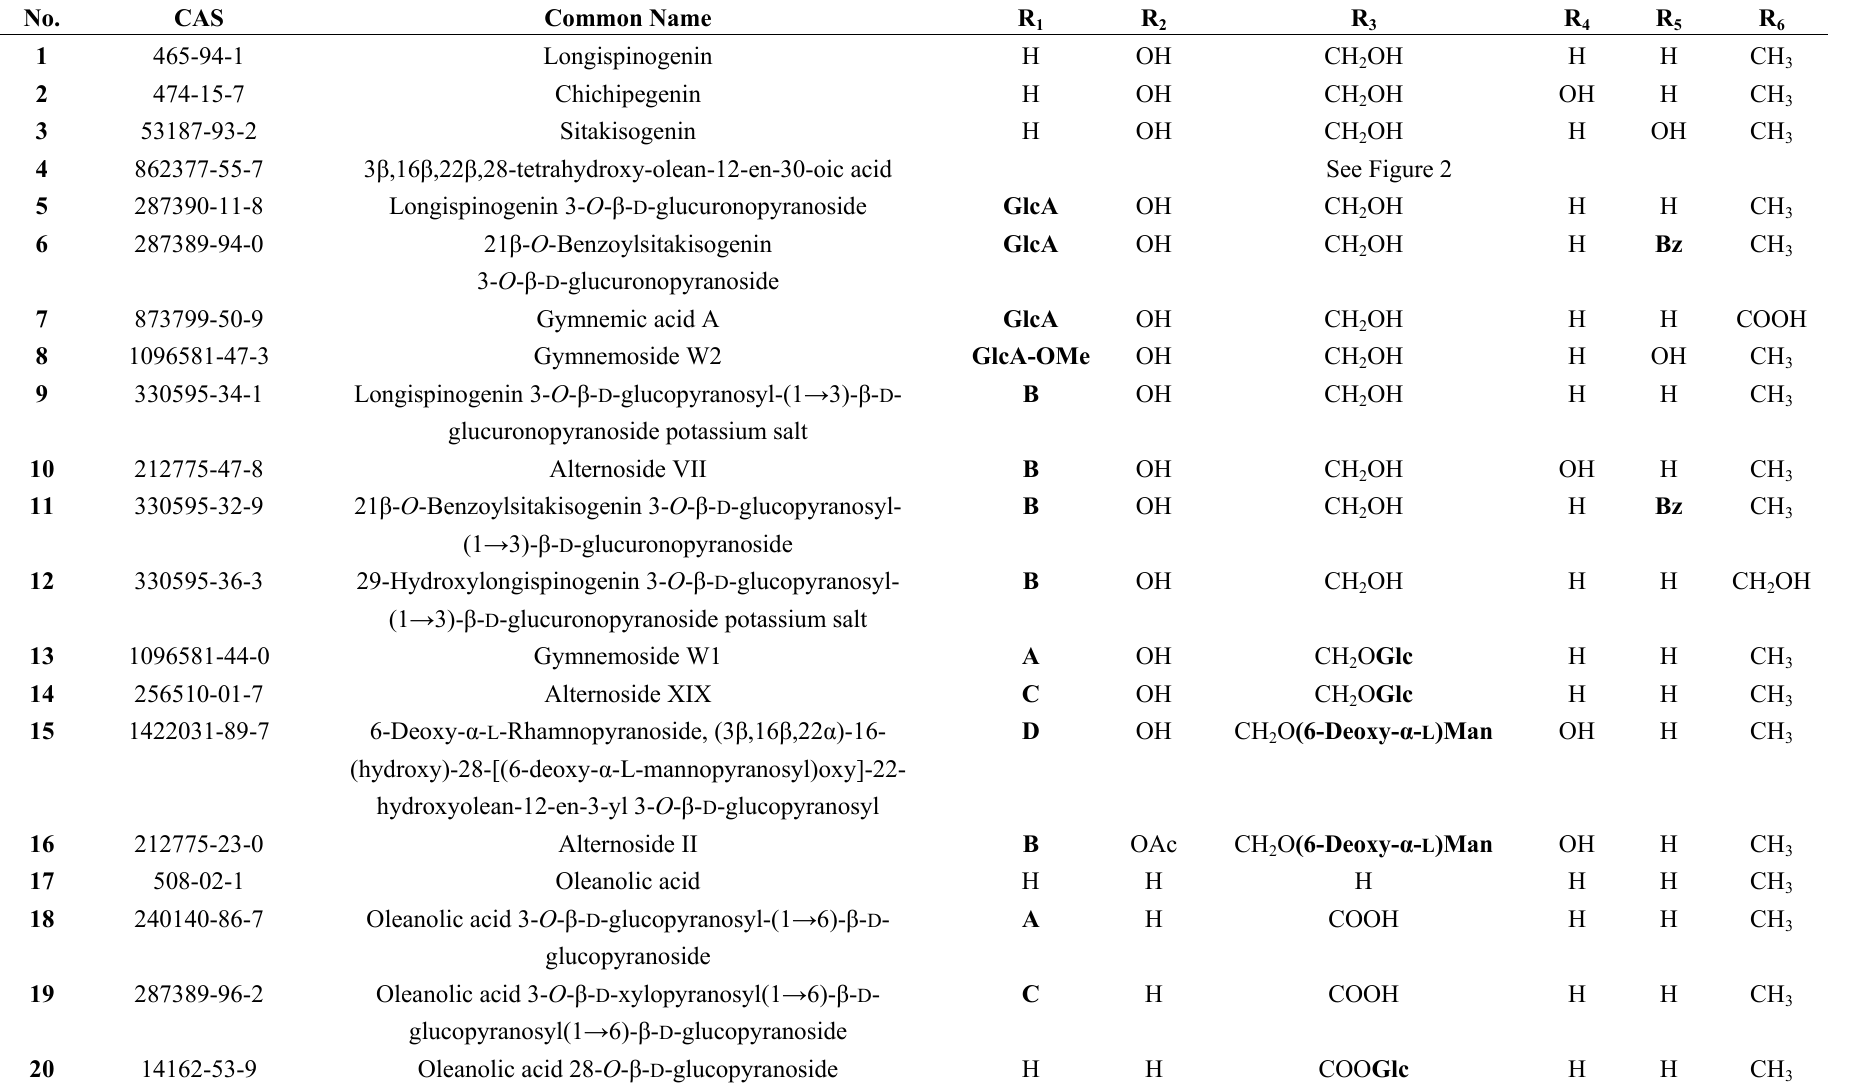
Table 3. Structures of gem-dimethylated oleanes isolated from Gymnema sylvestre